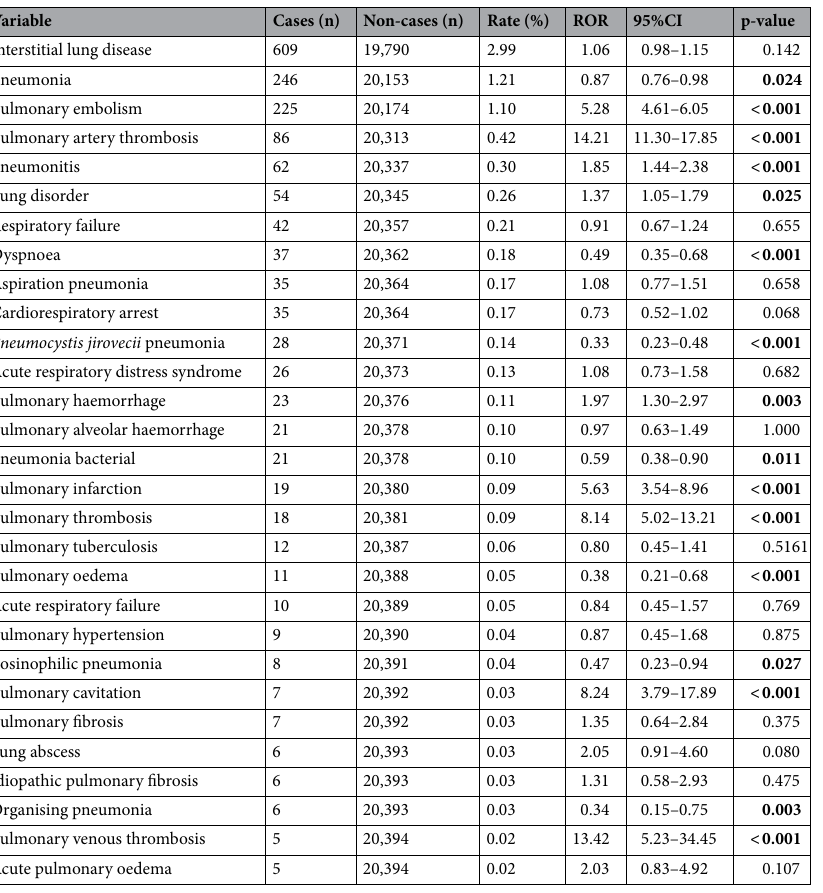
than five reports for each type of pulmonary toxicity. All analysed data were obtained from the Japanese Adverse Drug Event Report database. Hypothesis tests were two-sided, with statistical significance set